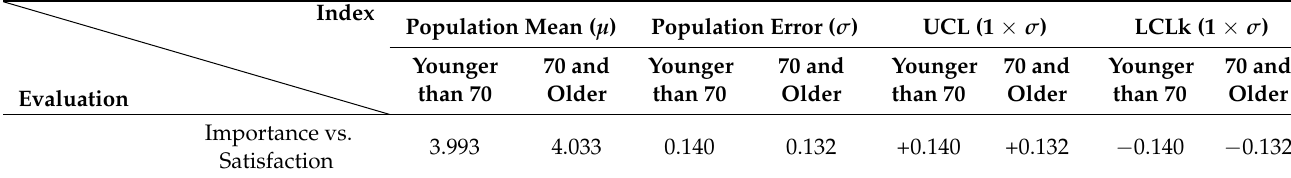
15 of 19 Table 8. Index Values for Age in the Performance Evaluation Matrix (PEM). Index Evaluation −0.132 UCL: Upper Control Line; LCL: Lower Control Line. We used Equations (3) and (4) to calculate the population mean and error values of the 32 importance–satisfaction items. In the matrix composed of importance and satisfac-